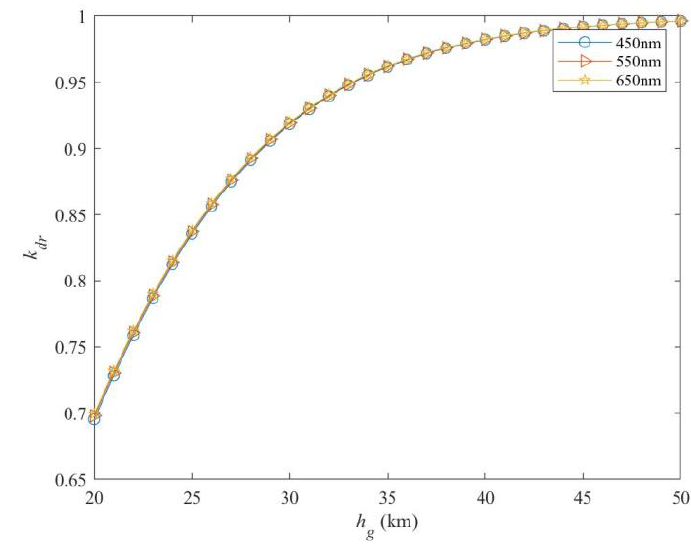
k Figure 6. d r with the tangent height Figure 6. k dr with the tangent height.